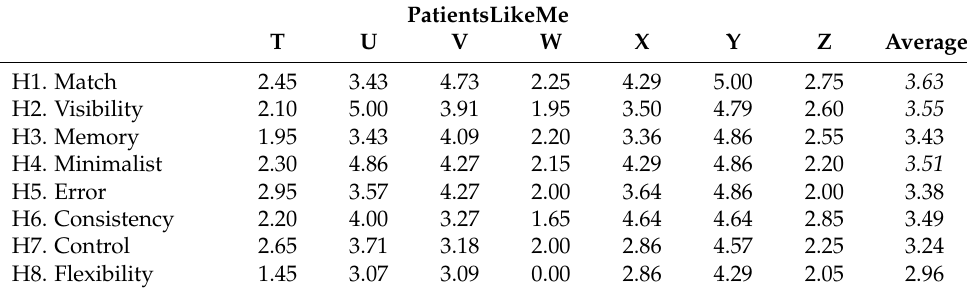
Table 8. Average usability assessments in PatientsLikeMe (2 of 2).